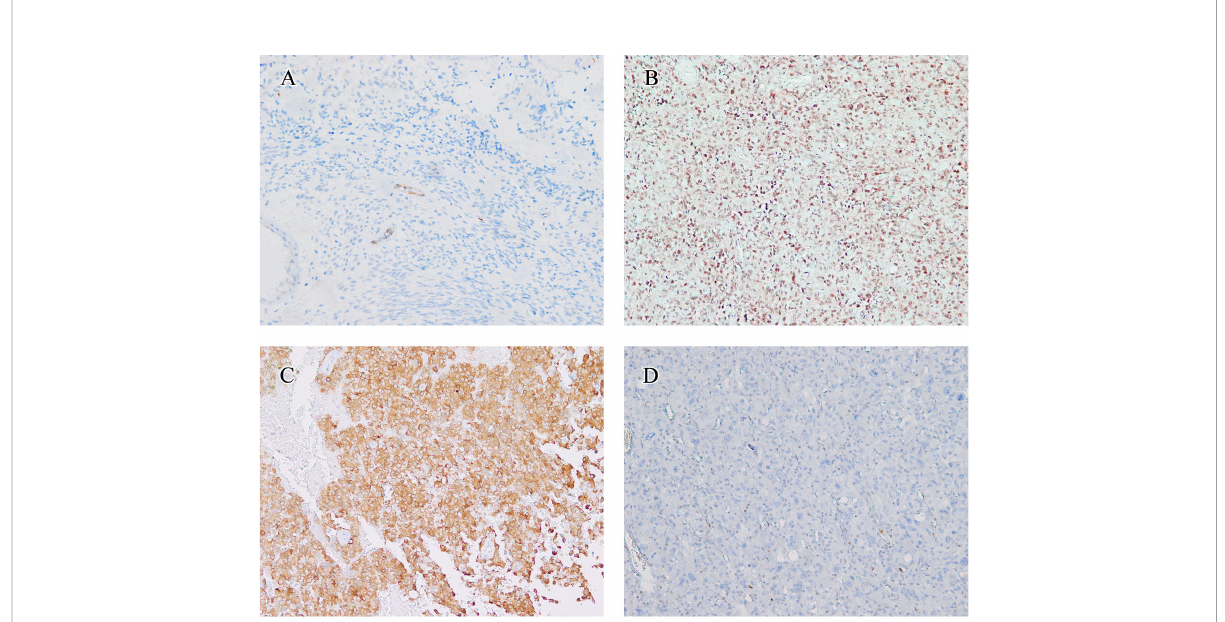
FIGURE 3 Immunohistochemical fi ndings. The immunohistochemical fi ndings of eGBMs. (A) Immunohistochemical studies showed negtive PTEN expression in 2 cases. Vascular endothelial cells provided an internal positive control (×200). (B) INI1 staining was universally intact (×200). (C) Positive expression of BRAF V600E in eGBM (×200). (D) The tumour cells demonstrated a complete absence of TP53 staining and lymphocytes showed TP53 nuclear staining focally (×200).